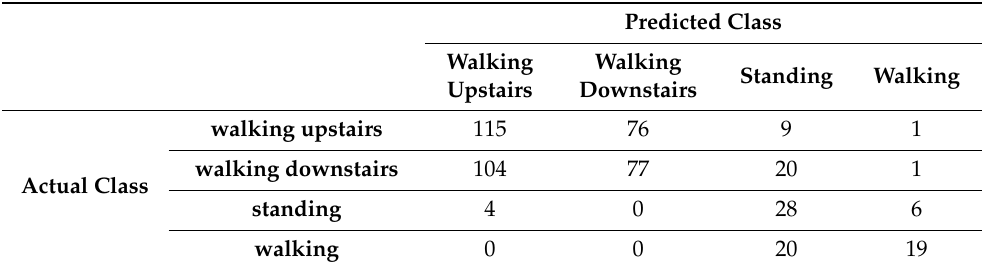
Table 5. Confusion matrix for normalized accelerometer data with RobustScaler.